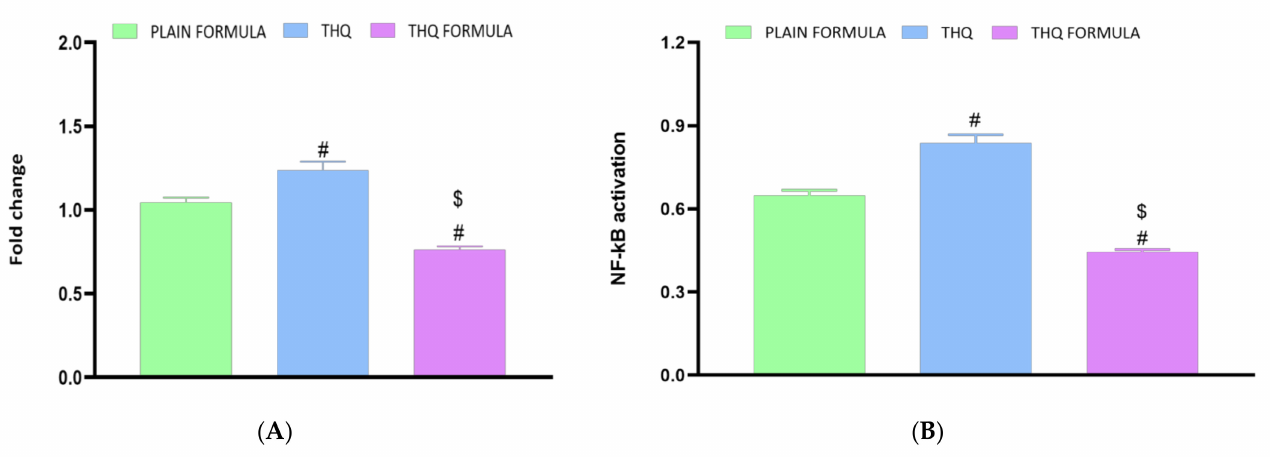
Figure 9. Effect of the THQ formula on the mRNA expression of TNF- α ( A ) and the activation of NF- κ B ( B ) in A549 cells. Data presented in bar charts are mean ± SD ( n = 3). # or $: Statistically different from plain formula or THQ, respectively at p <